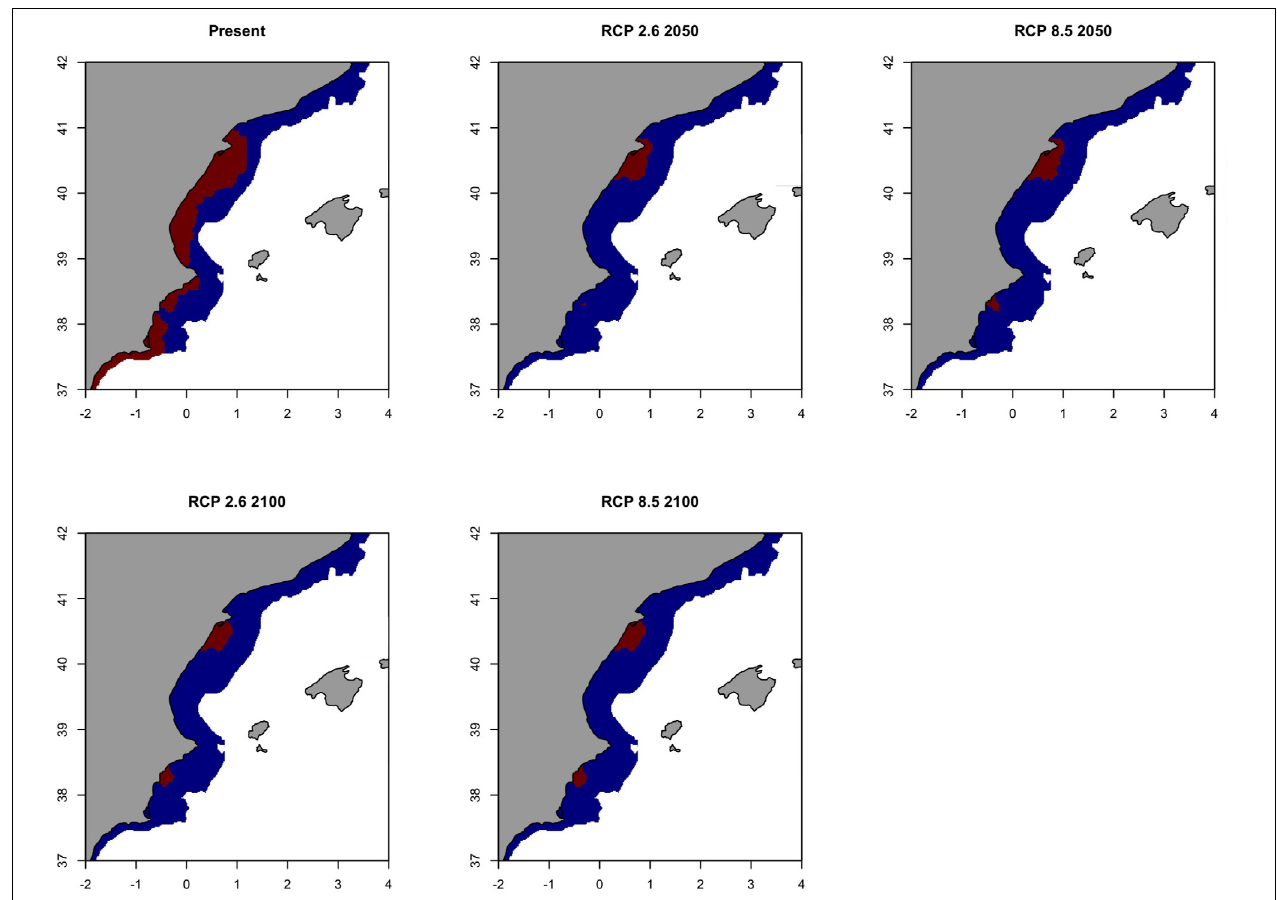
FIGURE 13 | Climate refuges, hot-spots of the probability of occurrence ( > 0.7) of the European anchovy ( Engraulis encrasicolus ) in Geographical Sub-Area 06 for the present situation and using IPCC pathway scenarios obtained with RAC-BRT models. Red color indicates probability of occurrence > 0.7, while blue <